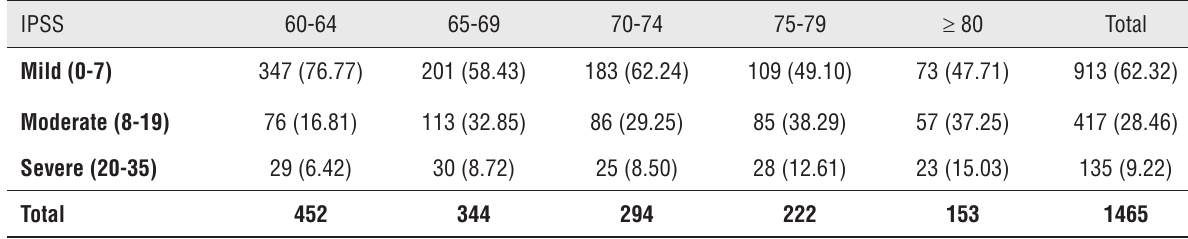
Table 1 - Result of IPSS in men.